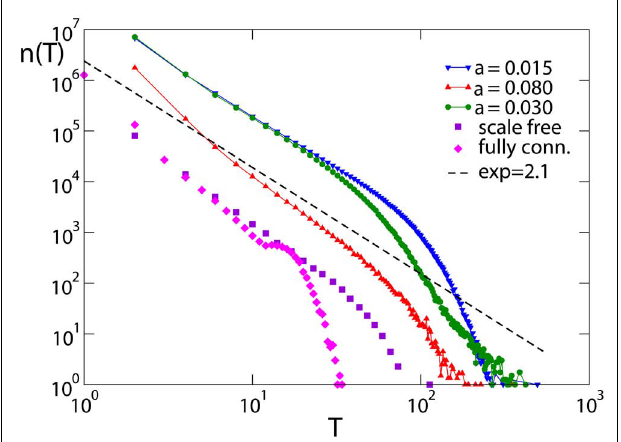
FIGURE 8 | Power spectra obtained for different networks: square lattice ( N = 10 6 , α = 0.03, N p = 10); small-world networks ( N = 10 6 , α = 0.05, N = 1000, 1% rewired bonds);Apollonian networks for p different N p (9th generation, α = 0.020). The experimental data (black line) are from Novikov et al. (1997) with frequency in Hertz. Experimental data are shifted in order to be in the same frequency range of numerical